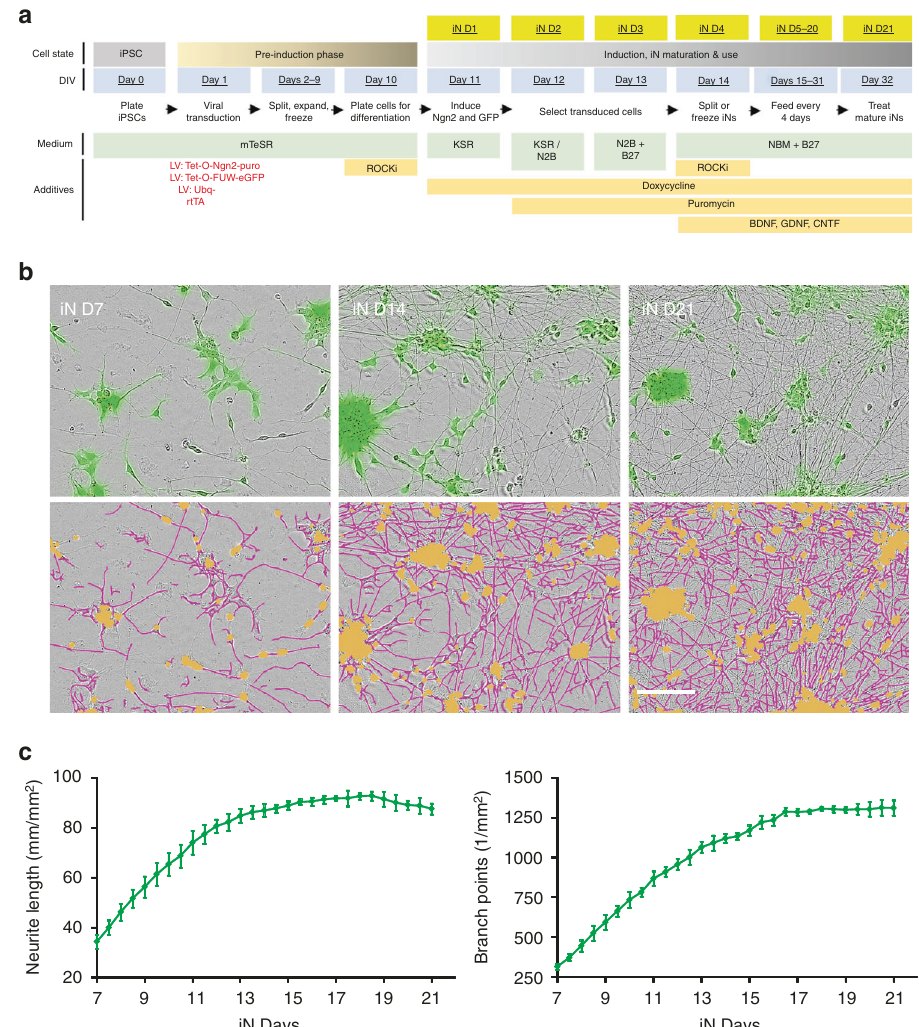
Fig. 4 Time-lapse imaging of differentiated human induced neuron (iNs). Human induced neuron (iNs) were prepared as described in the Supplementary Methods and used for live-cell imaging from iN day 0 to iN day 21. a Schematic depicts the process used to generate and mature iNs and indicates the nomenclature used to designate the different stages of the process. b Phase contrast and fl uorescence images of iN days 7, 14, and 21 are shown in the upper panels. These images were then analyzed using the IncuCutye NeuroTrack algorithm to identify neurites (pink) and cell bodies (brown). NeuroTrack- identi fi ed neurites (pink) and cell bodies (brown) are shown superimposed on the phase contrast image in the lower panels. The Scale bar is 100 μ m. c Images were collected at 12 h intervals from iN days 7 – 21 and analyzed using the IncuCutye NeuroTrack algorithm to determine neurite length (left) and the number of neurite branch points (right). Each data point is the average of measurement from 12 wells of iN cells cultured in the same 96 well plate. Error bars are